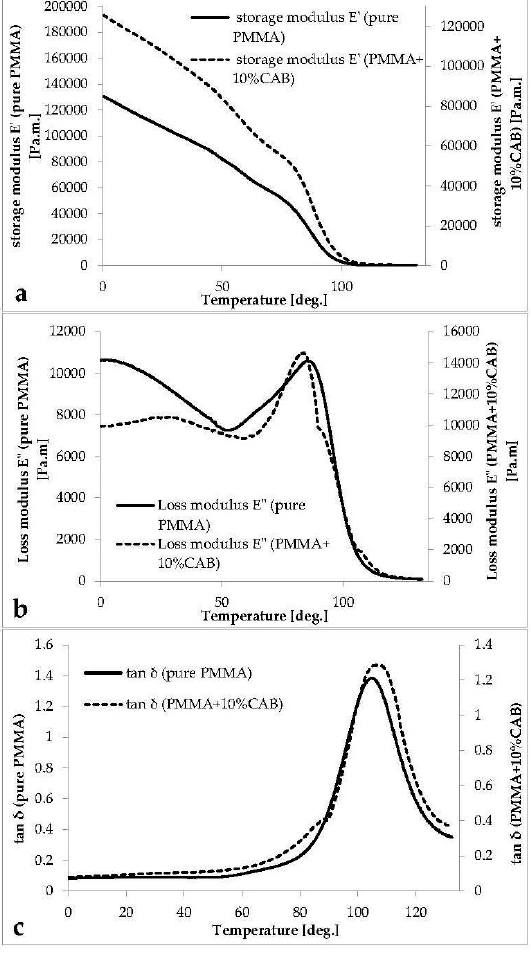
Figure 4. Pure PMMA and PMMA/10%CAB trace for ( a ) storage modulus E'; ( b ) loss modulus E"; and ( c ) the loss factor (tan δ ). ( c ) the loss factor (tan δ